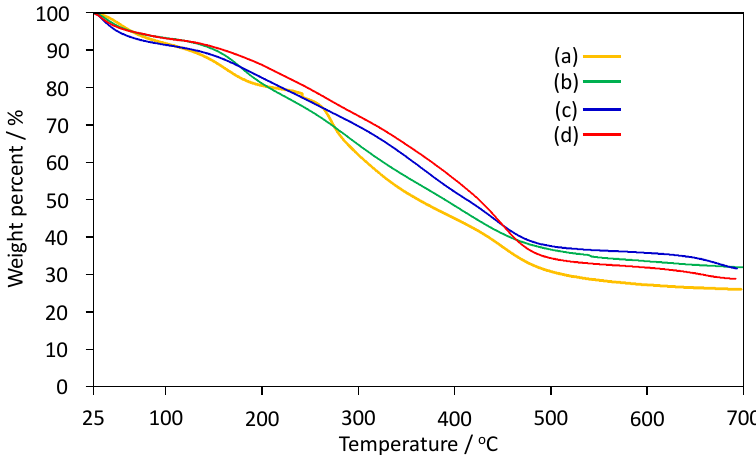
Figure 4. TGA thermograms of poly(IA- co -10-HHIA)s. ( a ) Code 1, ( b ) code 2, ( c ) code 3, ( d ) code 4.